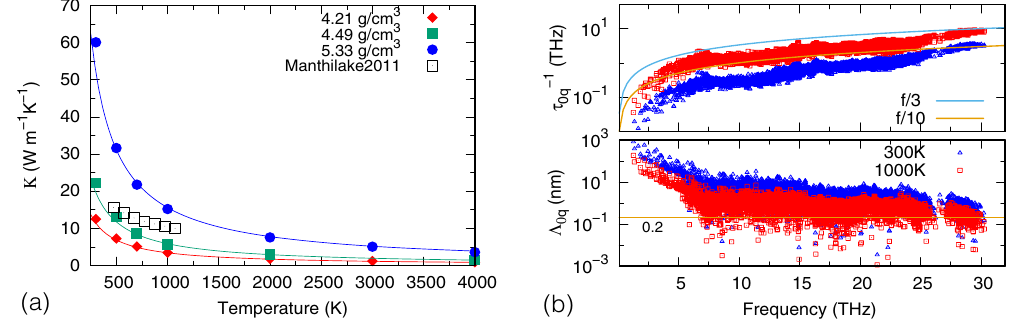
Figure 5. ( a ) Temperature dependence of κ . Lines are 1/ T fits of κ in the range T ≥ 1000 K. Experiment by Manthilake et al . 3 was conducted at 26 GPa ( ρ ≈ 4.45 g/cm 3 ). ( b ) Inverse of anharmonic lifetimes ( τ − free paths ( Λ 0 q ≡ v q τ 0 q ) versus phonon frequencies at ρ = 4.49 g/cm 3 . The calculated pressure for this density is 24.1 GPa at 300 K and 28.8 GPa at 1000 K. Lines with labels “f/3” and “f/10” in the upper panel denote 1/3 and 1/10 of the frequency, respectively. The horizontal line in the lower panel represents the inter-atomic distance 0.2